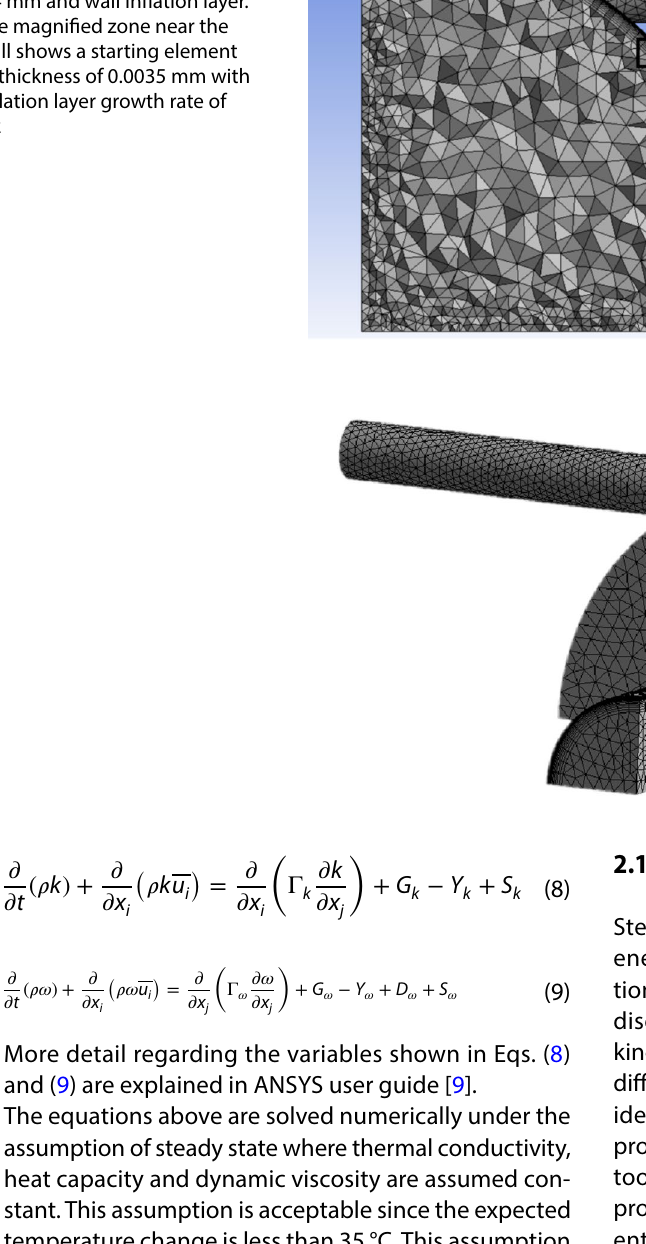
Fig. 2 Unstructured mesh of the modeled vortex tube with maximum element size of 0.4 mm and wall inflation layer. The magnified zone near the wall shows a starting element of thickness of 0.0035 mm with inflation layer growth rate of